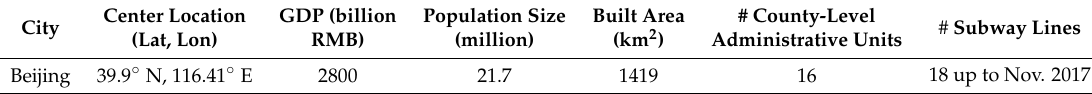
Table 1. Important socioeconomic features of